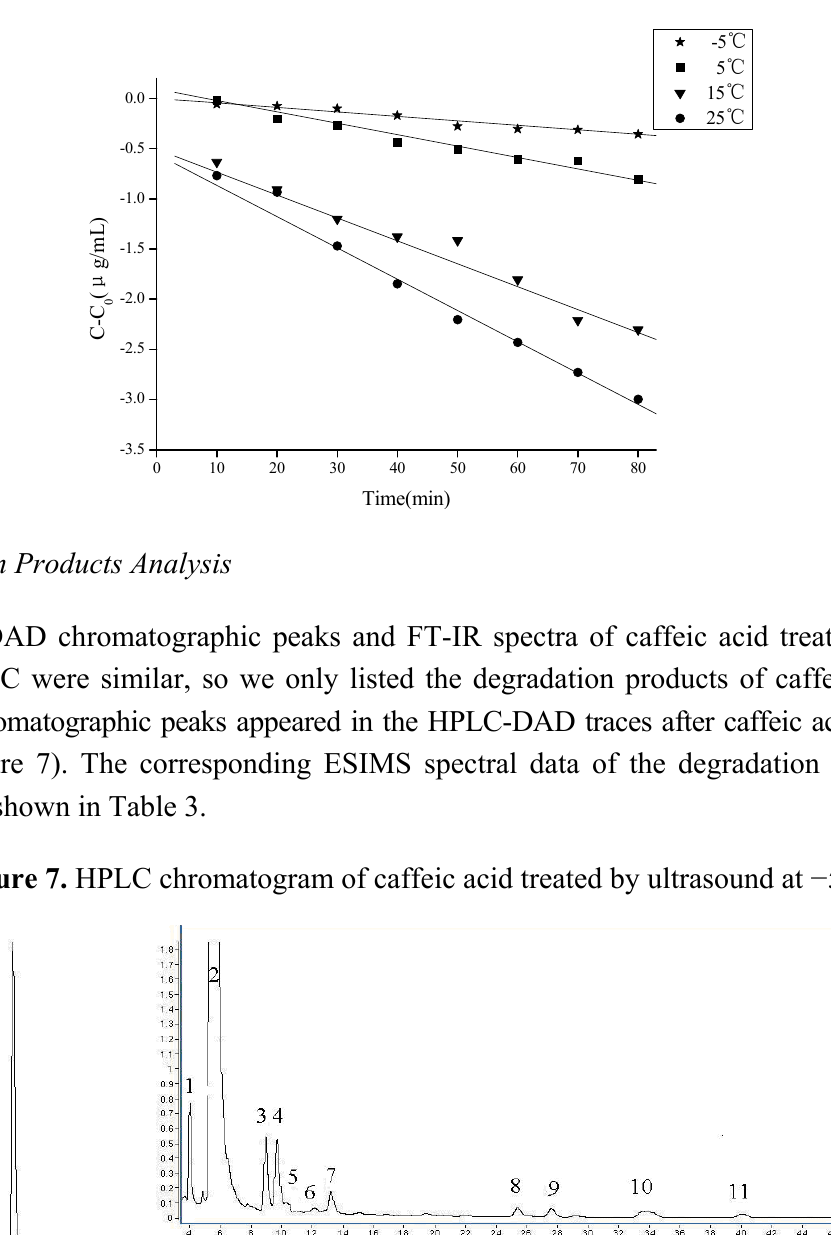
Figure 6. Degradation kinetics curves of caffeic acid under ultrasound treatment (US) at − 5, 5, 15, 25 °C.